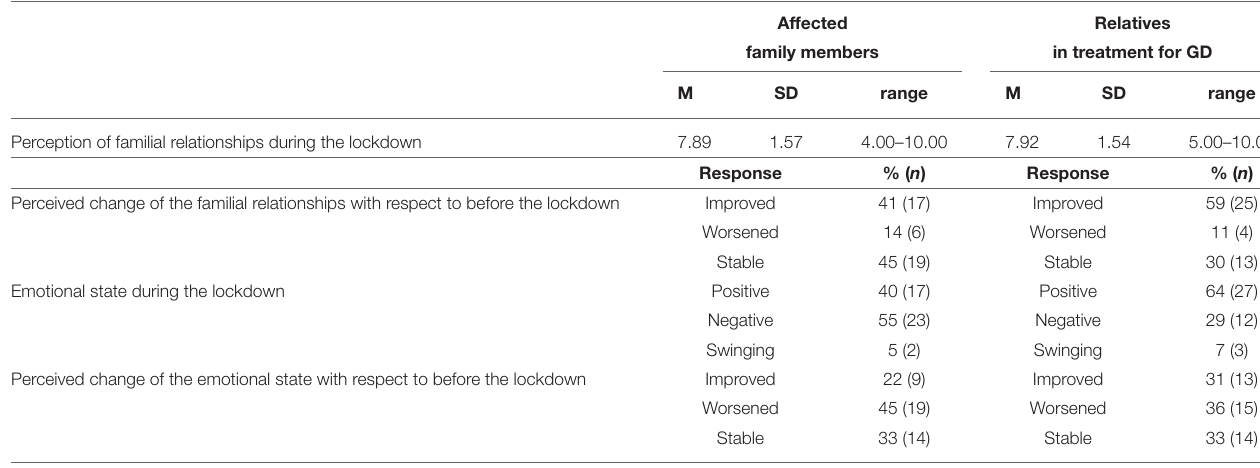
TABLE 7 | Perception of familial relationships among the affected family members and the relatives in-treatment for gambling disorders.